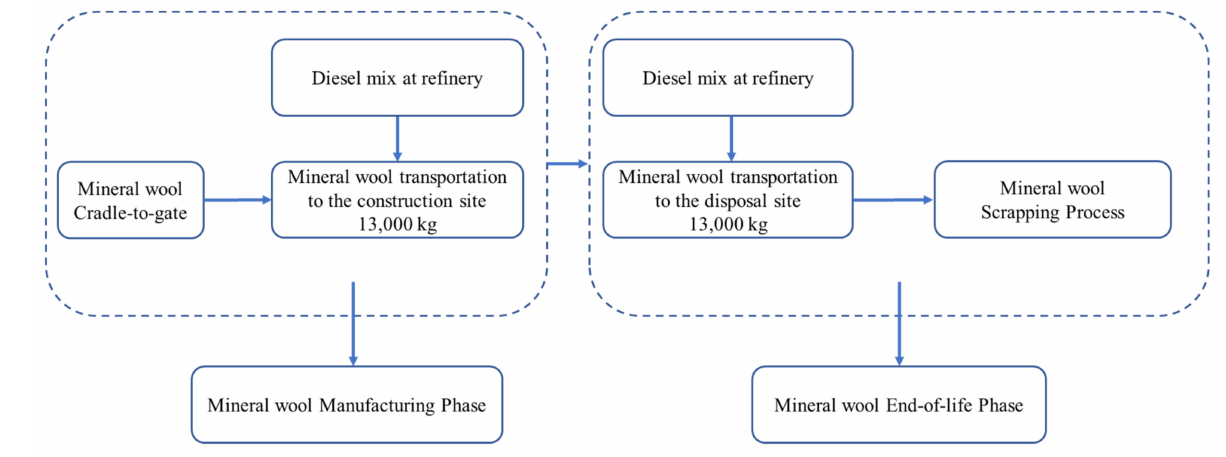
Figure 6. Flow diagram of mineral wool.